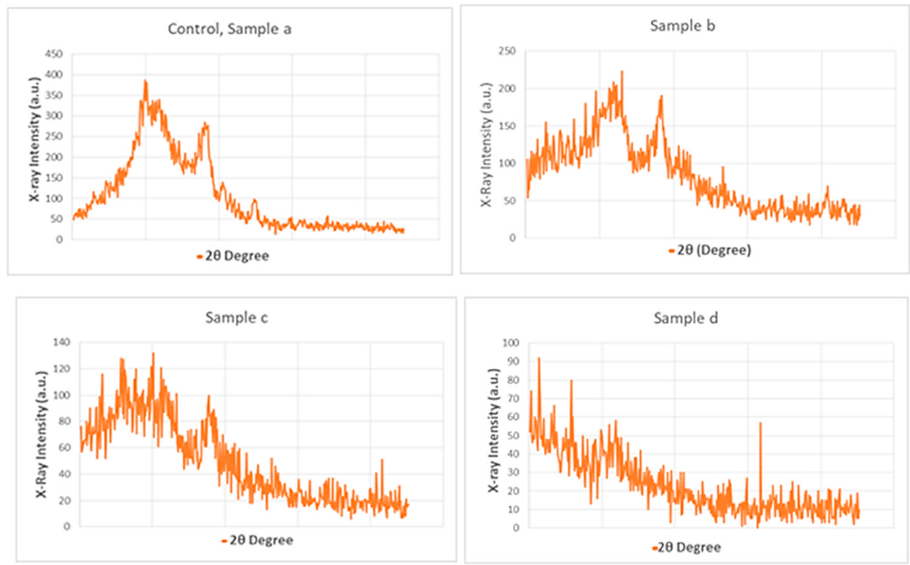
Figure 11. XRD analysis of fabrics coated with CaCl 2 : ( a ) untreated; ( b ) 10 wt % CaCl 2 ; ( c ) 25 wt % CaCl 2 ; ( d ) 50 wt % CaCl 2